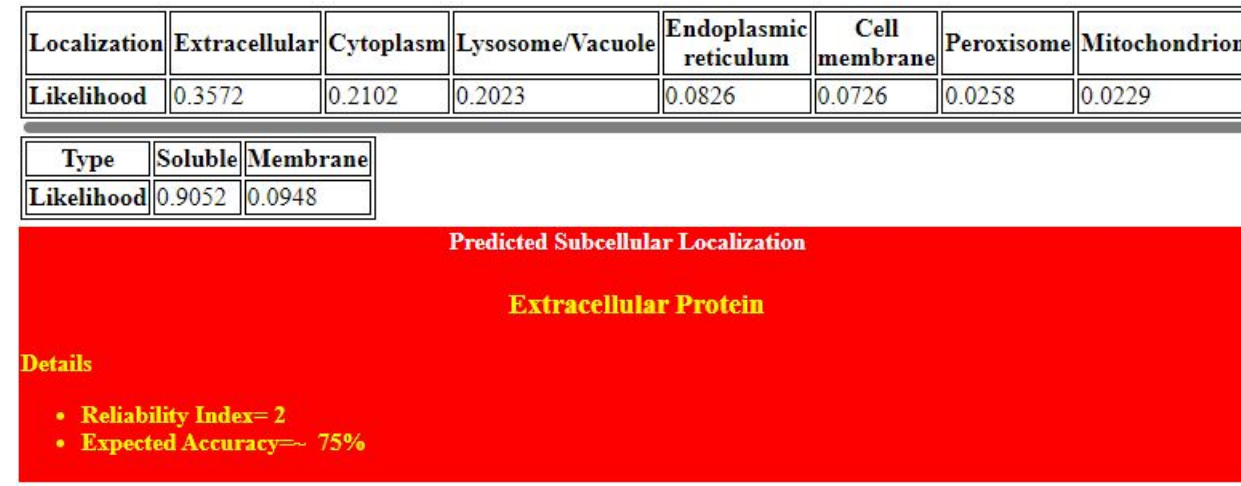
Figure 2. Subcellular localization of target protein via DeepLoc-1.0 and ESLpred web server.